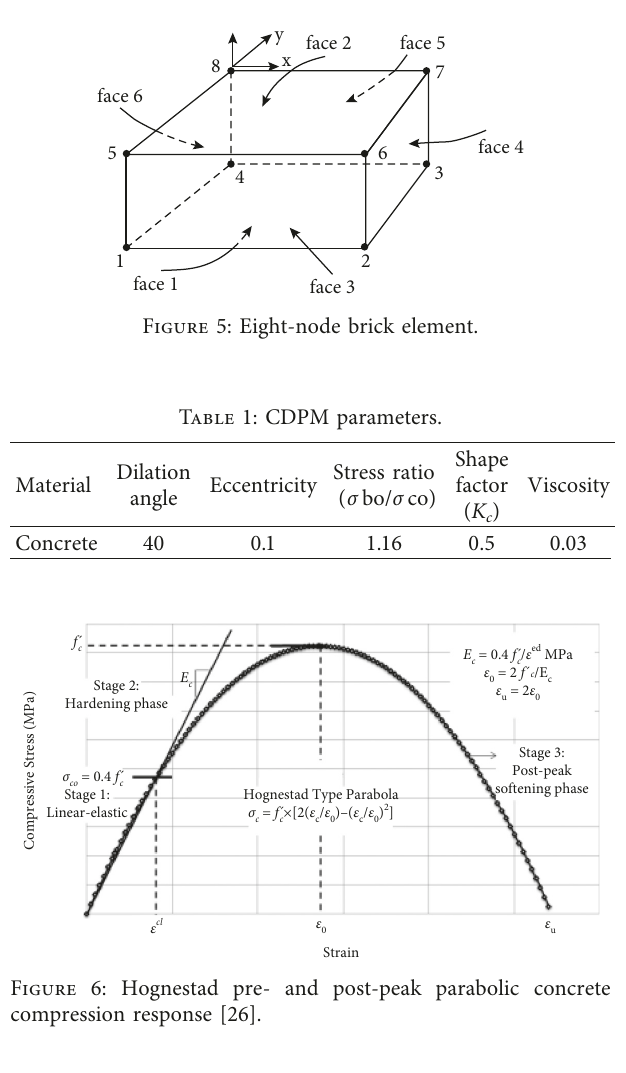
Figure 4: Delineation of the mesh: (a) comparison of different mesh sizes with experimental result and (b) finite element mesh size of 0.025.